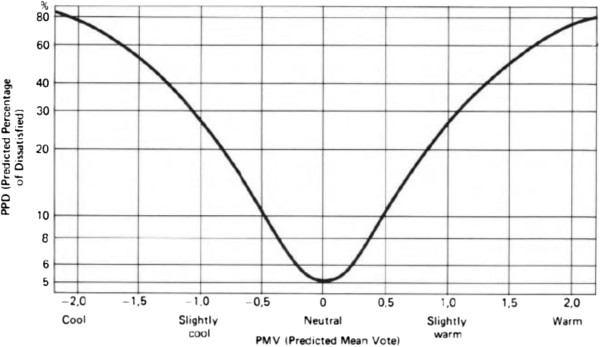
The relationship between PPD and PMV[1].